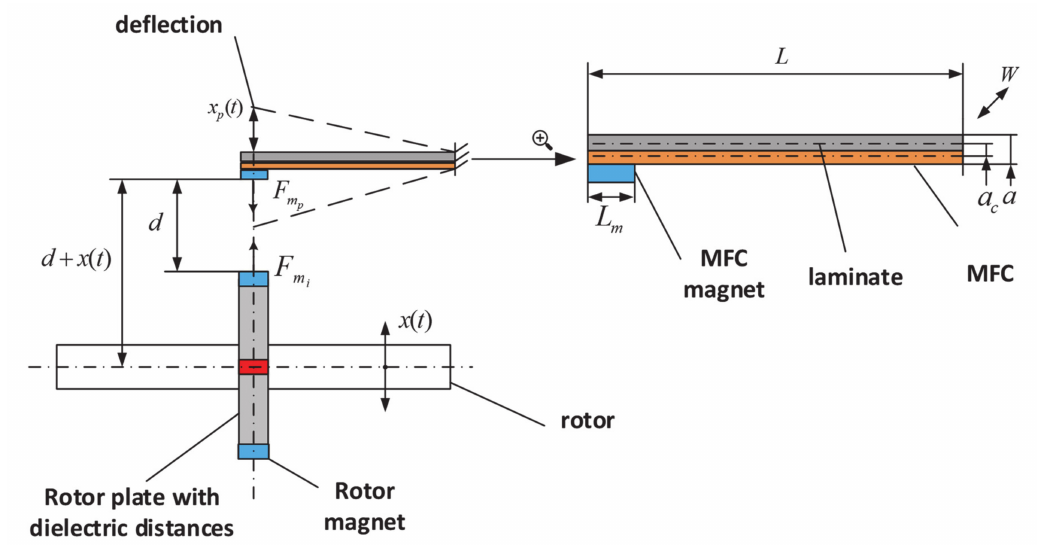
Figure 1. Mechanical model of the macro fiber composite (MFC)-magnet energy harvester; x —rotor radial displacement, x p —MFC-laminate deflection, d —air-gap between the rotor magnets and MFC magnets, L —length of the beam, W —width of the beam, L m —length of the MFC magnet, a —thickness of the